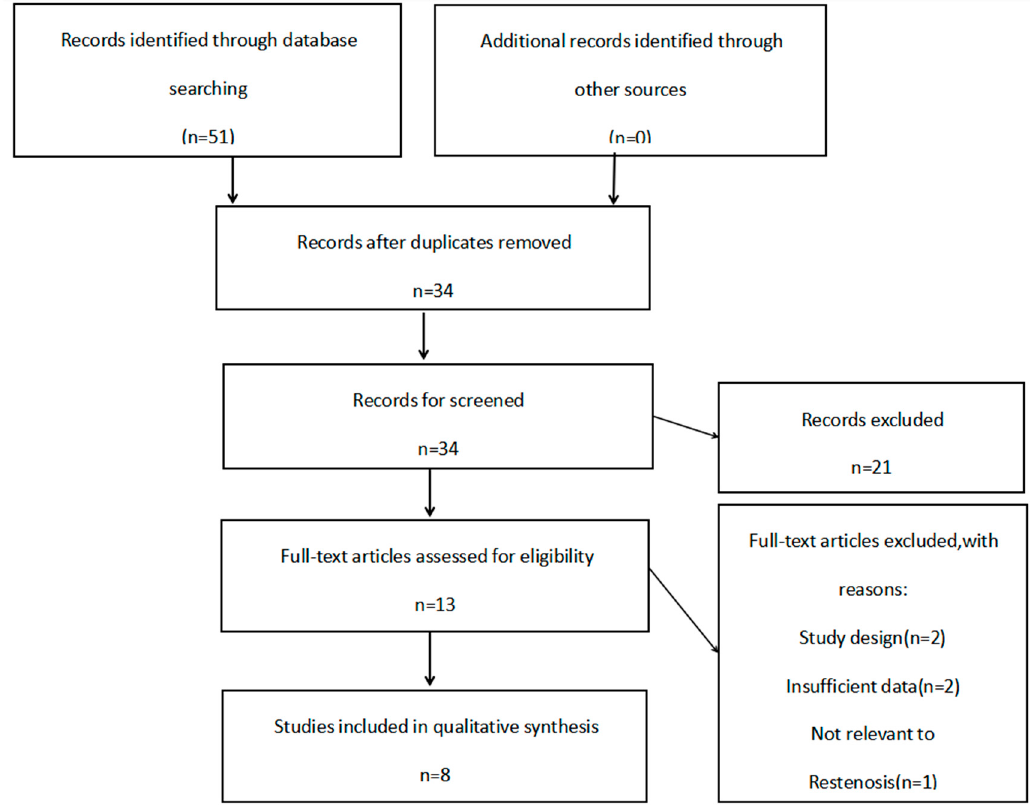
Figure 1. The PRISMA flow diagram of the study selection and exclusion.